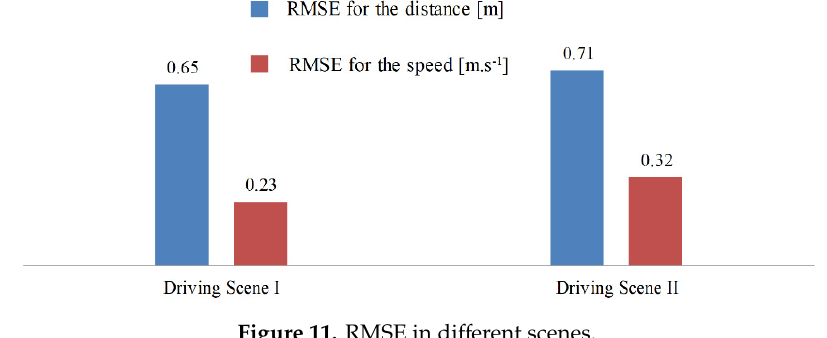
Figure 11. RMSE in different scenes.